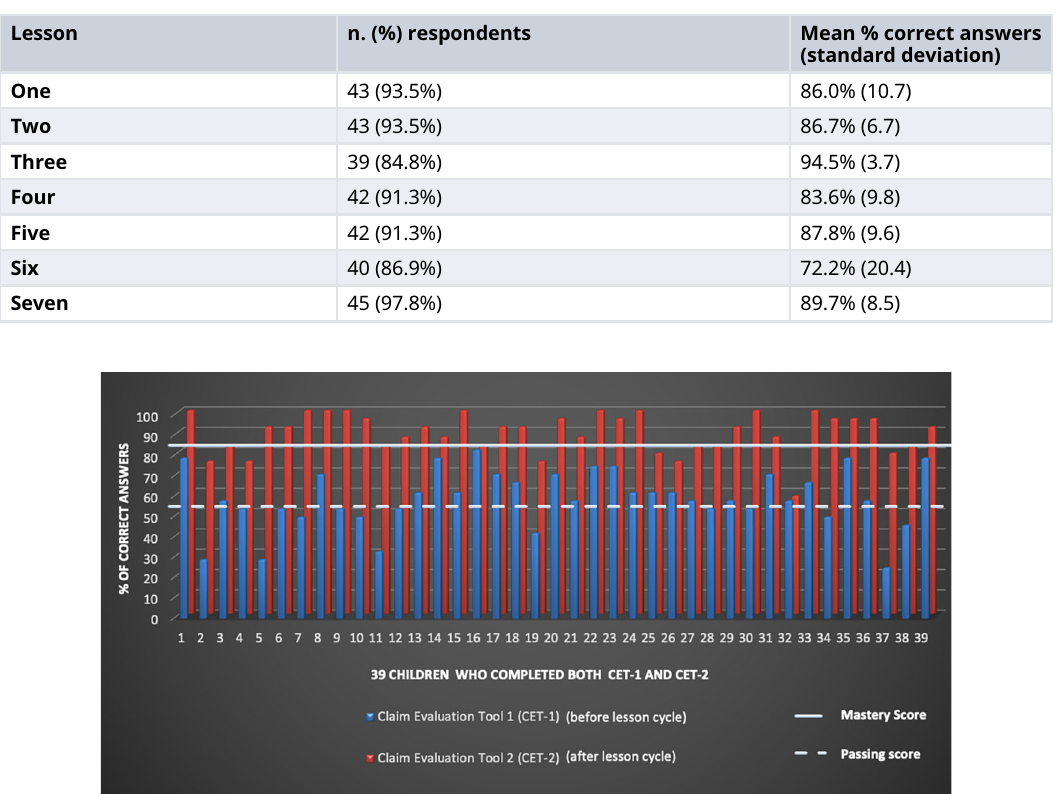
Figure 4. Individual percentages of correct answers for 39 children who took Claim Evaluation Test 1 (before lesson cycle) and Claim Evaluation Test 2 (after lesson